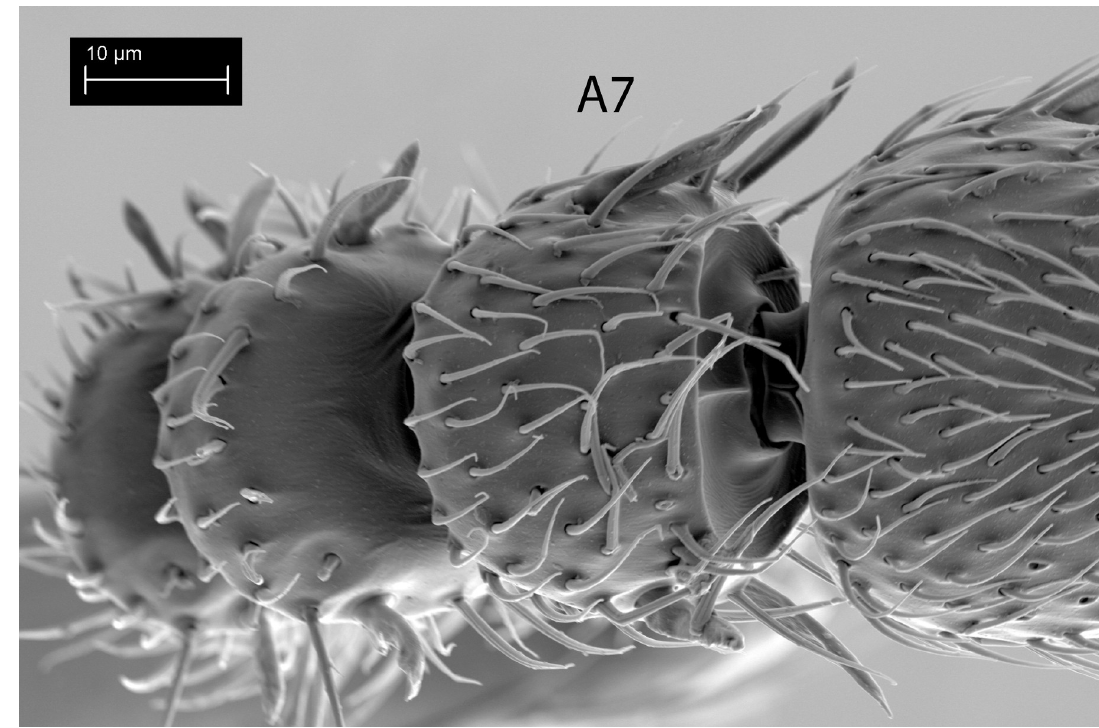
Fig 11. Telenomus nizwaensis Polaszek female. Detail of A7 showing lack of papillary sensilla.